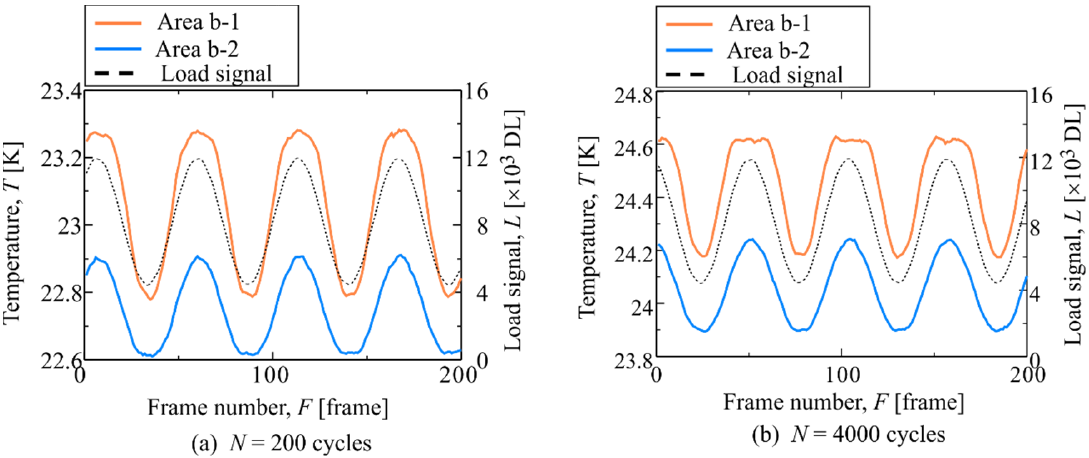
Figure 8. Thermal and load signal at Area b-1 and Area b-2, measured at ( a ) N = 200 cycles, ( b ) N = 4000 cycles.